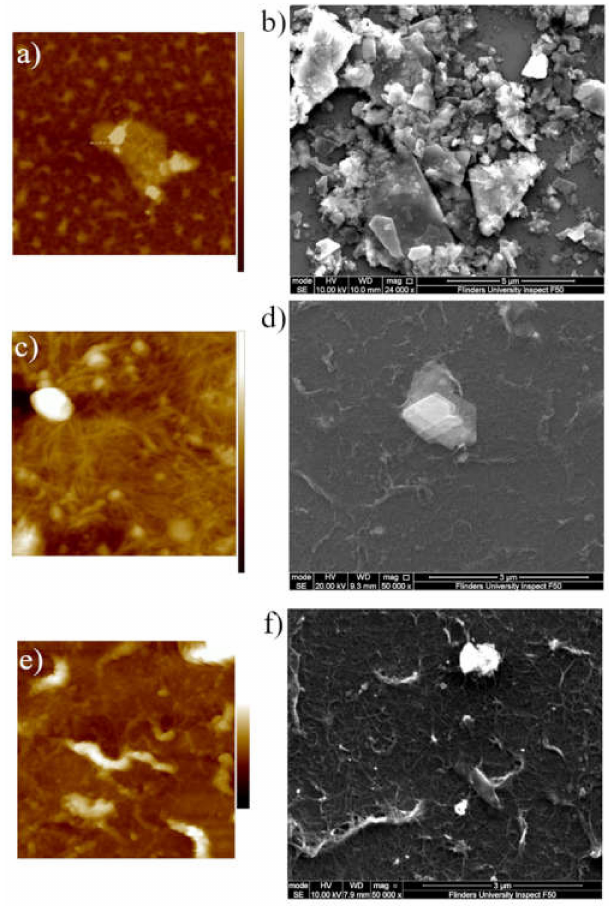
Figure 2. ( a ) AFM image of typical MoS 2 flake; image size is 855 nm × 855 nm with a z-range of 24 nm. ( b ) Wide view SEM image of MoS 2 flakes in the dispersion. ( c ) AFM of SWCNT / MoS 2 hybrid made by mixing 600 µ L of MoS 2 dispersion with 300 µ L SWCNT dispersion; image size is 2.0 µ m × 2.0 µ m with a z-range of 220 nm. ( d ) SEM image of SWCNT / MoS 2 hybrid made by mixing 600 µ L of MoS 2 dispersion with 300 µ L SWCNT dispersion. ( e ) AFM of SWCNT / MoS 2 layered system made by first depositing a film made from a 600 µ L of MoS 2 dispersion followed by a film made using 300 µ L SWCNT dispersion; image size is 6.0 µ m × 6.0 µ m with a z-range of 800 nm. ( f ) SEM image of SWCNT / MoS 2 layered system made by first depositing a film made from a 600 µ L of MoS 2 dispersion followed by a film made using 300 µ L SWCNT dispersion.